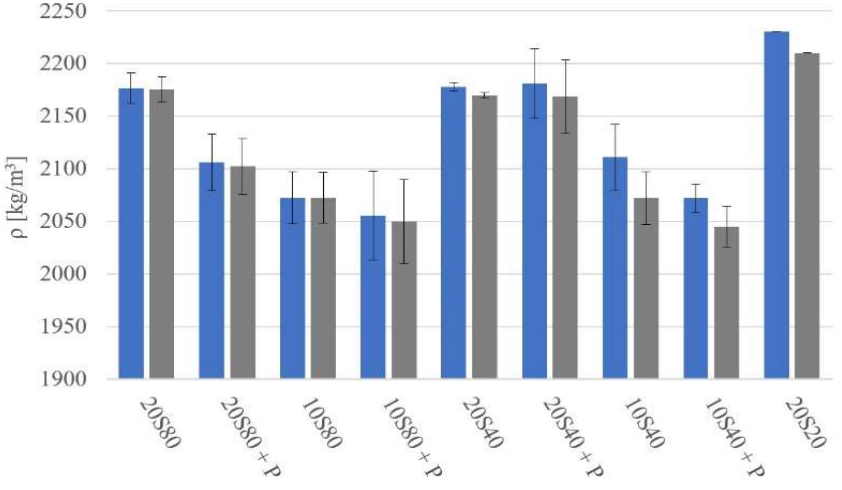
Figure 3. Apparent density of mortars measured after 1 day (blue) and 28 days (grey) of curing. The compressive strength ( f c ) test results are shown in Figure 4. The highest compres- sive strength values were 68.4 MPa and 67.5 MPa for mixes 20S20 and 20S80, respectively. The lowest strength values were 29.3 MPa, 29.9 MPa, and 31.1 MPa for mixes 10S40, 10S80P, and 10S40P, respectively.